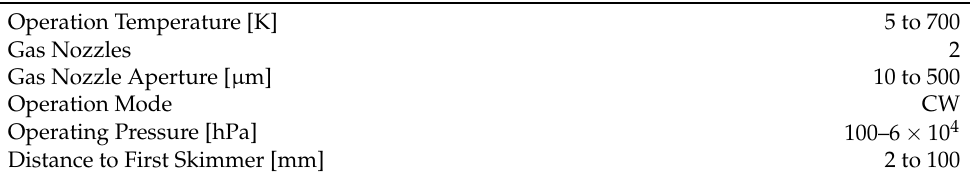
Table 1. Main gas jet